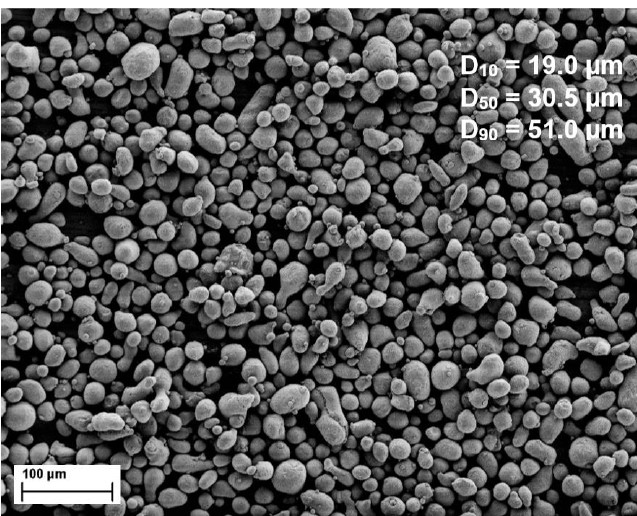
Figure 1. Powder morphology observed with SEM with powder size distribution reported.